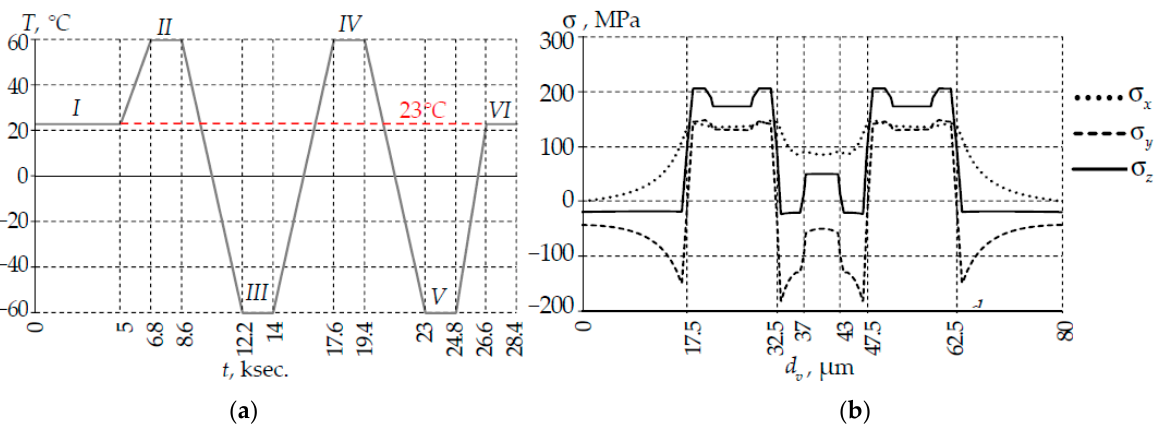
Figure 3. Temperature cycle ( a ) and diagrams of residual stresses along the fiber central section after drawing and polarization ( b ): I–VI are numbers of holding zone at constant temperature; I is 23 °C; II is 60 °C; III is − 60 °C; IV is 60 °C; V is − 60 °C; VI is 23 °C.